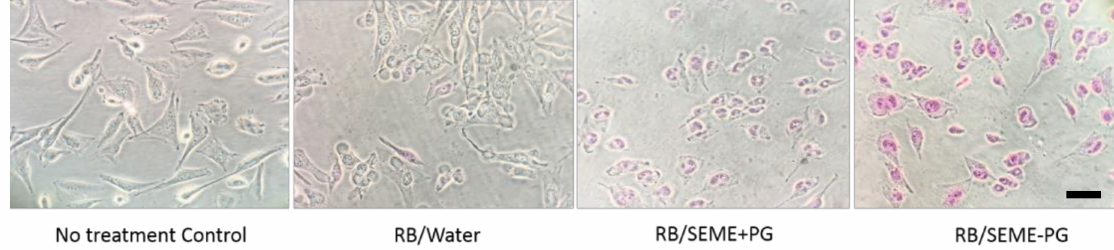
Figure 5. Microscopy images of RB uptake by the live melanoma cells. The cells are treated for 30 min with final concentrations of 50- µ M RB incorporated in 0.02% of water, SEME + PG, and SEME–PG. The cells showed more RB uptake after treatment with SEME + PG. Images captured at 40 × magnification and scale bar = 25 µ m.